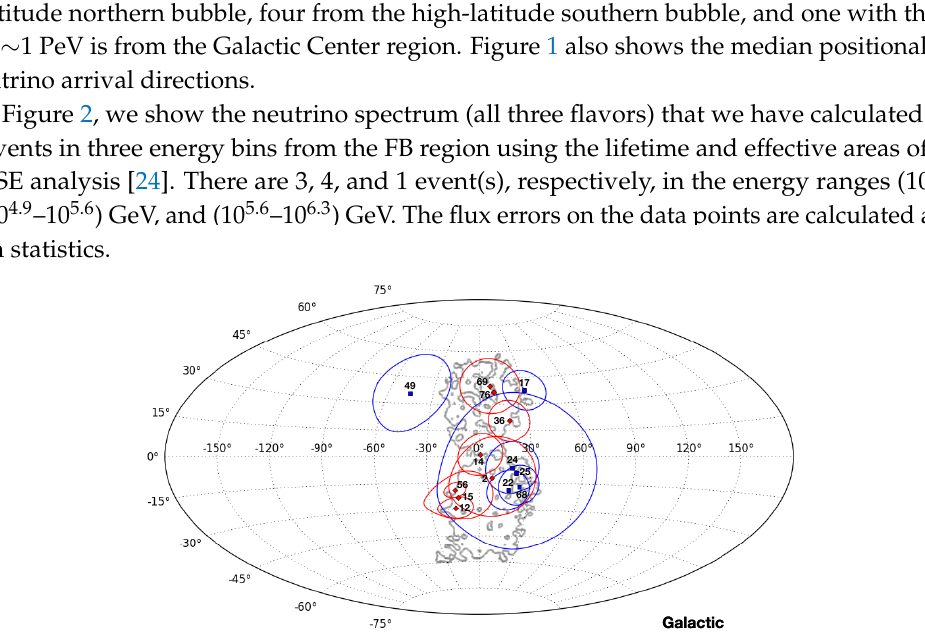
Figure 1. Sky map of the IceCube astrophysical neutrino events [24] that are correlated with the Fermi bubbles in Galactic coordinates. The eight strongly and six weakly correlated events are shown as red diamonds and blue squares, respectively, with their median angular errors and numbers labeled. The Fermi bubble outlines are shown as gray contours.